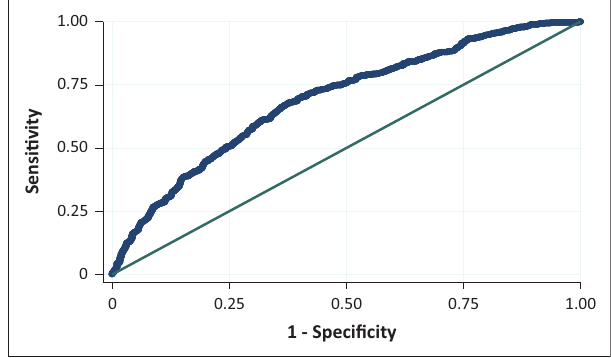
Mixed race people versus black